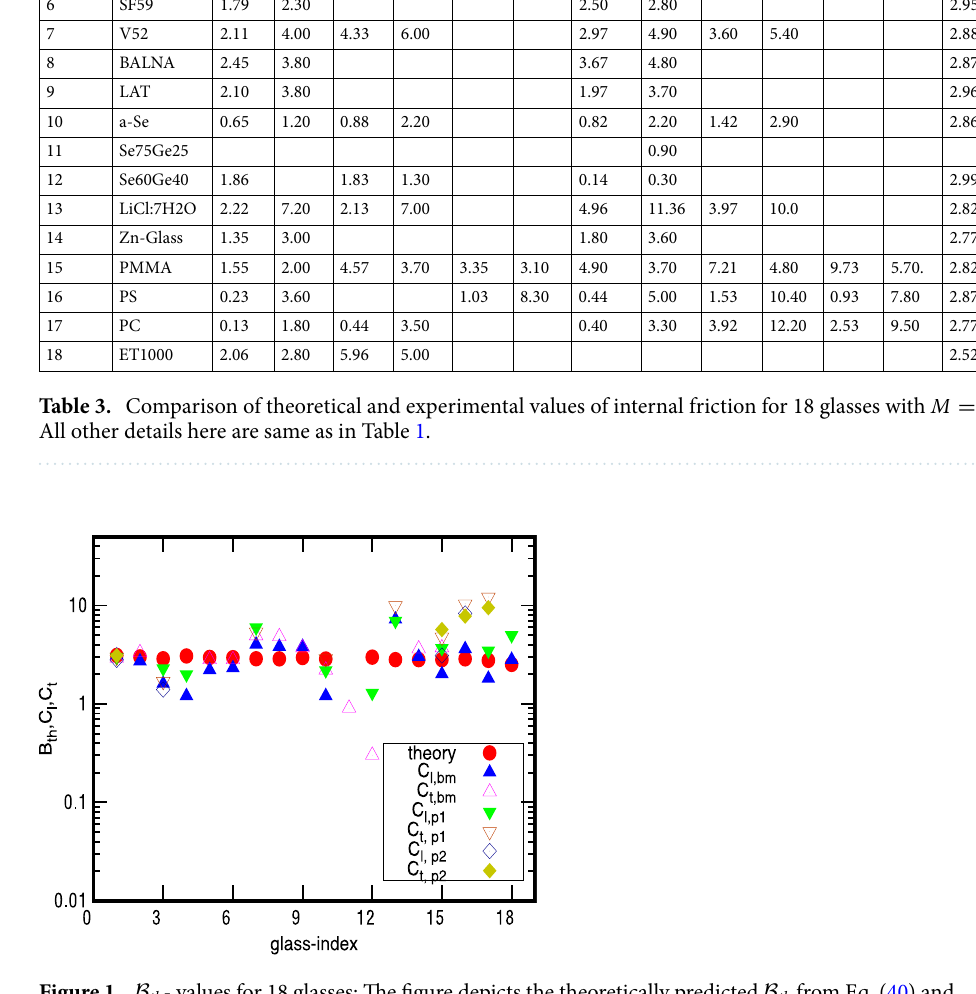
Figure 1. B th - values for 18 glasses: The figure depicts the theoretically predicted B th from Eq. (40) and corresponding experimentally known tunneling strengths C a with respect to glass-index (given in 1st column of Table 2). The symbol C a , bm refers to experimental data for tunneling strength from 35 and C a , p 1 , C a , p 2 to acoustic and flexural data, respectively, from 1 . The values for B th are also given in the last column of Tables 1 and 3; note these are same for both M 1 , M 2